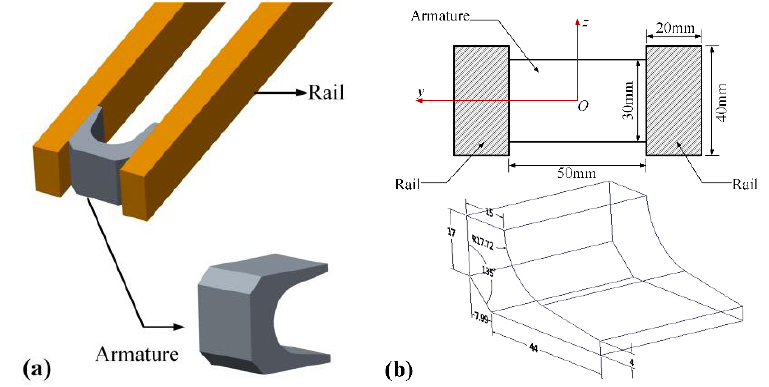
Figure 8. The rails and armature system. ( a ) The system structure of the rails and armature. ( b ) The sizes of the rails and the